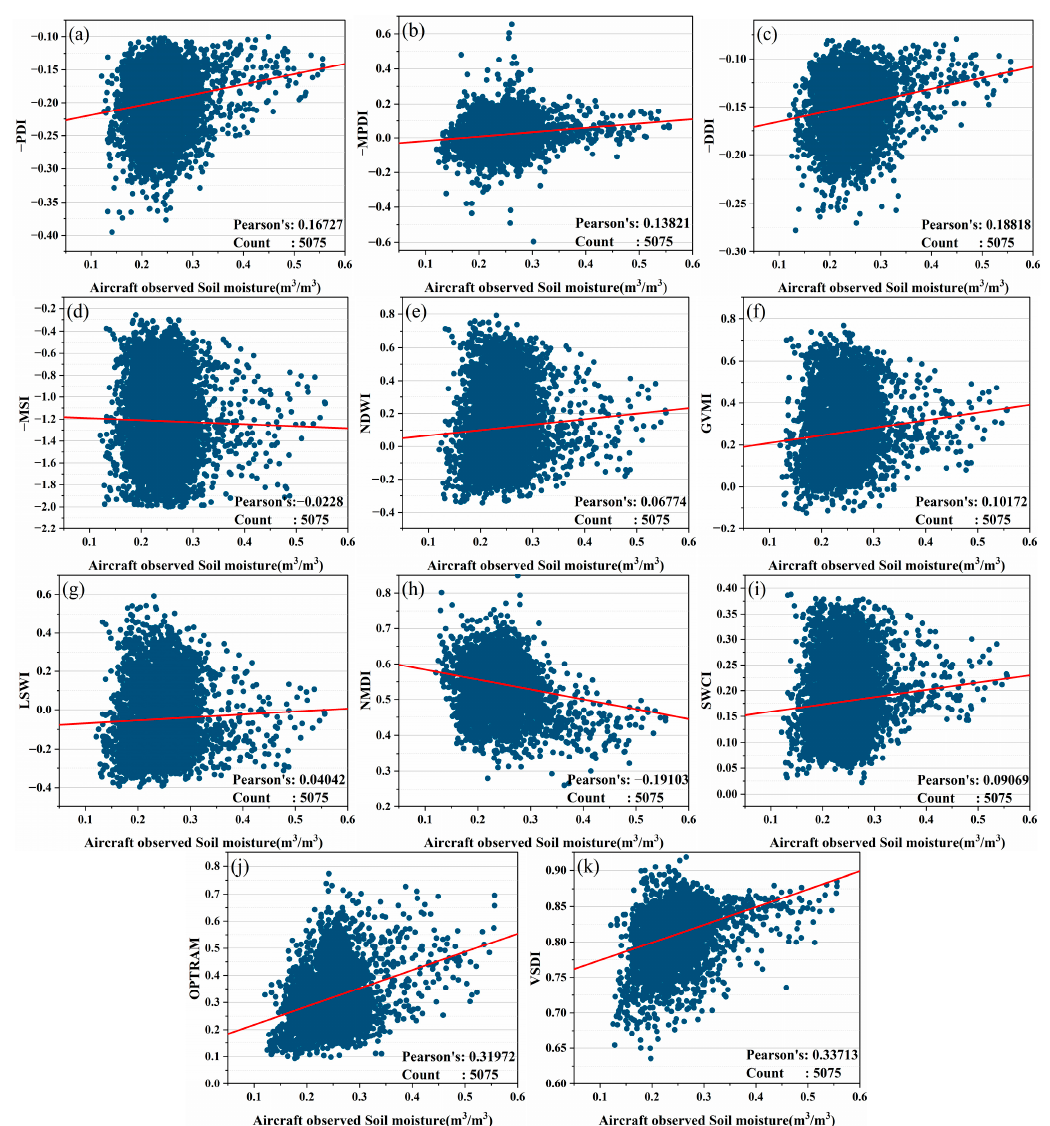
Figure 7. ( a – k ) Scatter plot between the aircraft SM and Sentinel MSI-derived SM indexes on 11 June 2016 during the SMAPVEX16 Manitoba experiment.